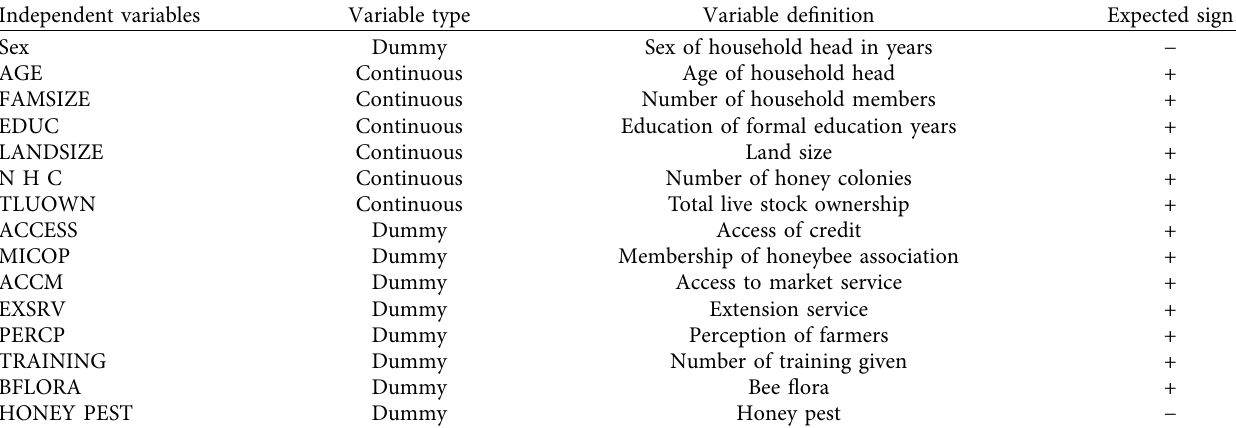
Table 2: Explanatory/independent